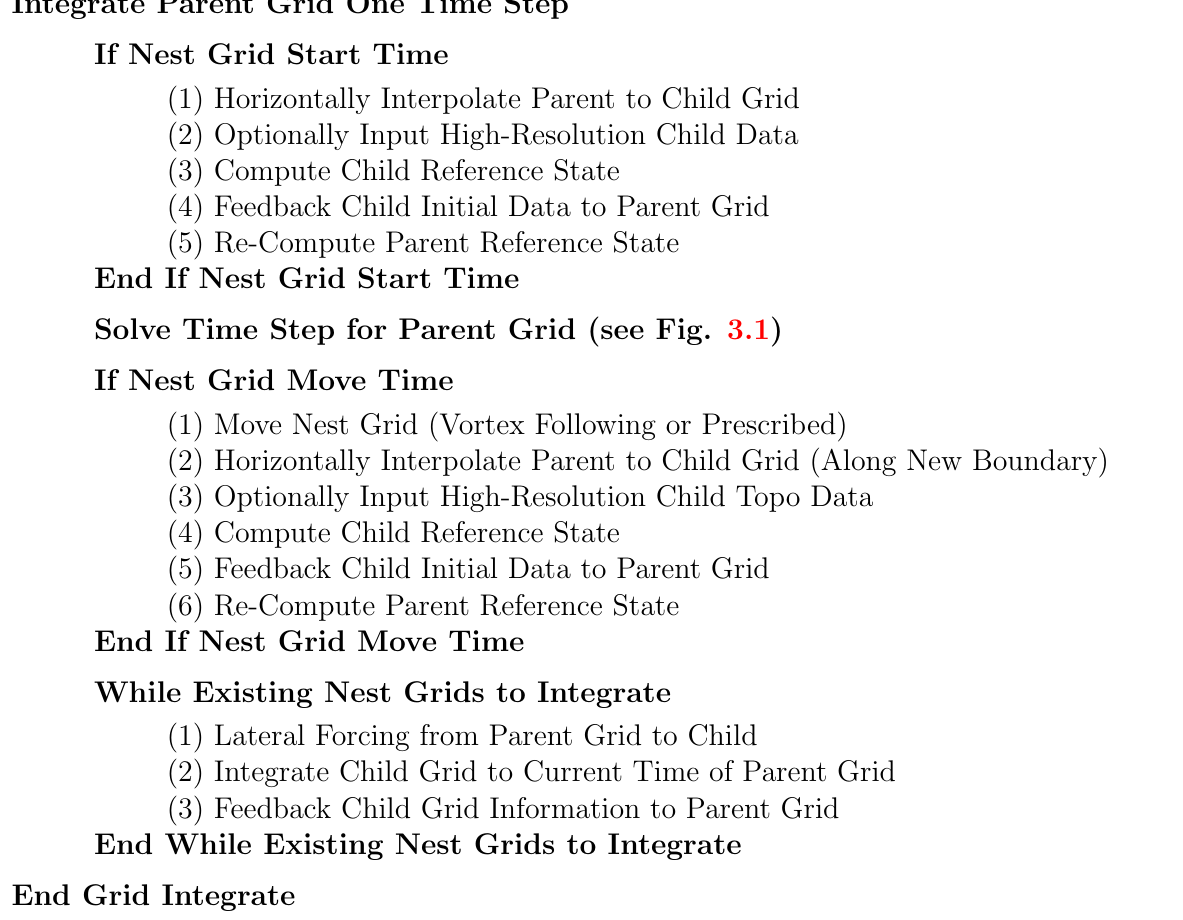
Figure 7.5: Nest grid integration